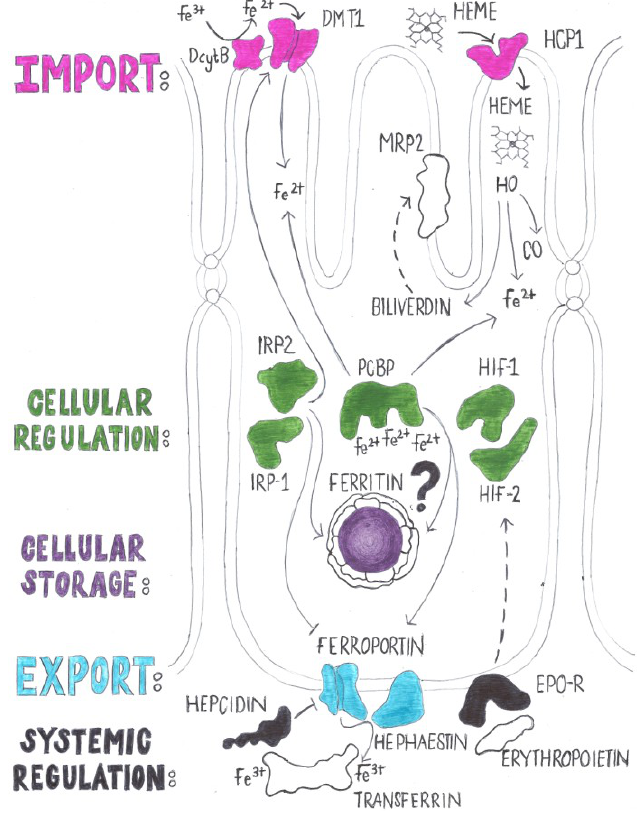
Figure 1. Simplified scheme of iron absorption in mammals. A typical enterocyte of the duodenum of the mammalian intestine has uptake transporters for iron (DMT1) and heme (HCP1) localized in the apical membrane. An iron export transporter (ferroportin) is localized in the basolateral membrane. Ferric iron is reduced by Dcytb prior to import and oxidized by Hephaestin upon export. Iron is stored locally in the enterocyte in ferritin. Whether the iron chaperone PCBP has a role in iron absorption remains to be determined (indicated by a question mark). Heme oxygenases release iron from heme. The large byproduct of this reaction (biliverdin) is modified and secreted into the gut lumen though the Multidrug Resistant Protein-2 (MRP2) transporter. Iron absorption is regulated at the systemic level by hepcidin, which is secreted by the liver hepatocytes in response to various physiologic stimuli. Local cellular regulation also occurs via the Hypoxia Inducible Factors (HIFs) and Iron Regulatory Proteins (IRPs) and may be influenced by circulating levels of erythropoietin